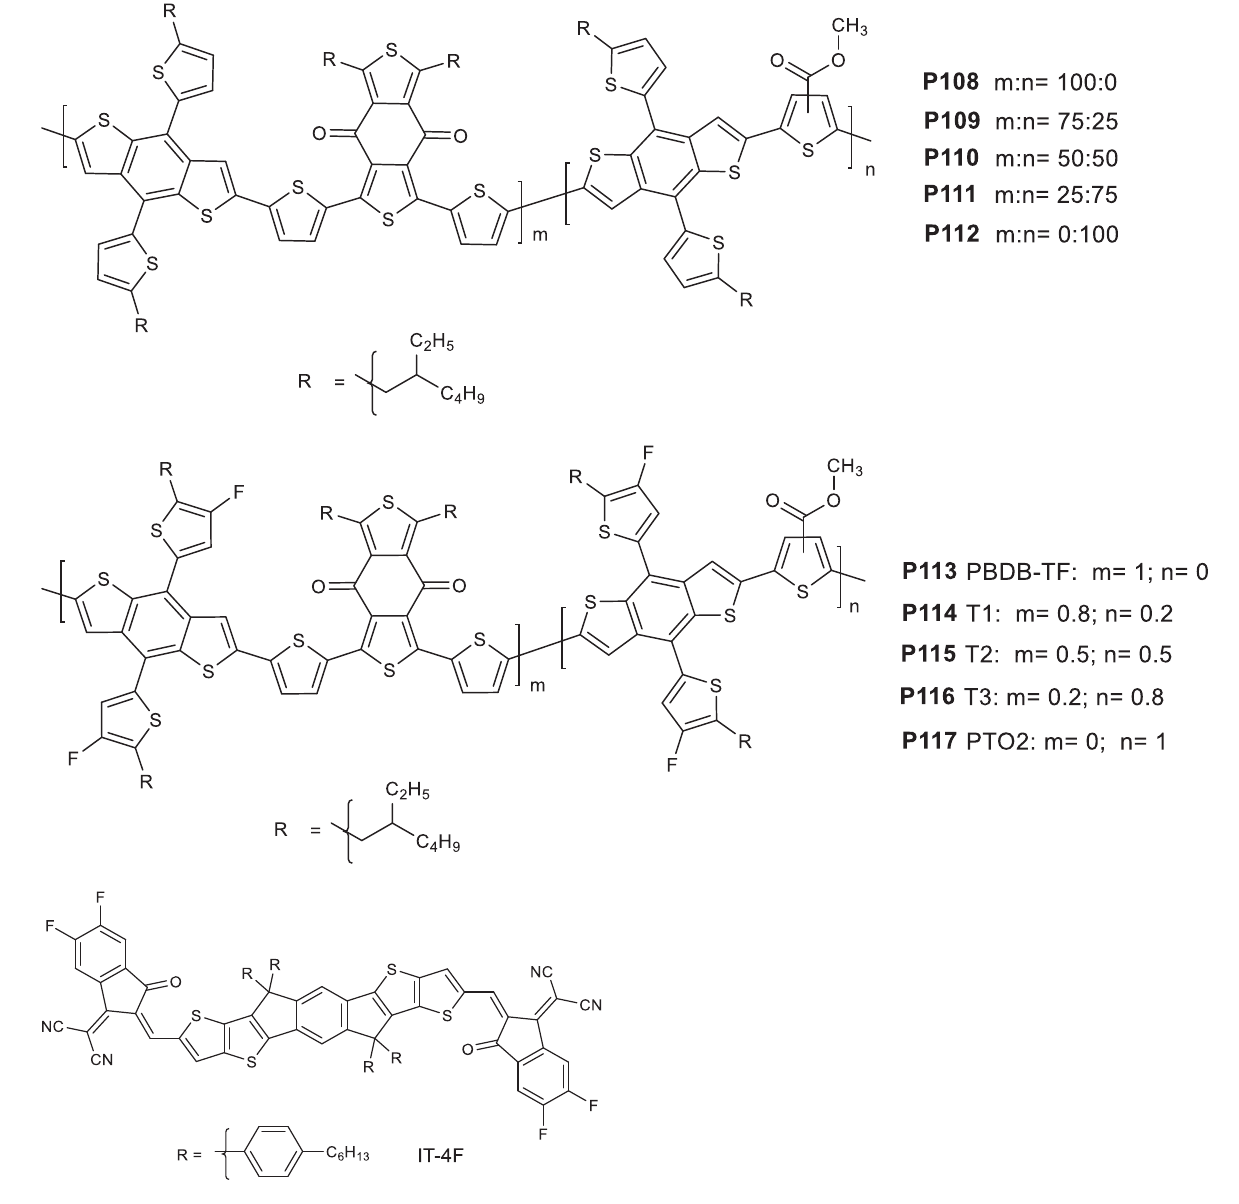
based on P95 yielded a 11.21% PCE, V OC = 0.868 V, J SC = 21.01 monomer, the FF showed an improvement reaching to